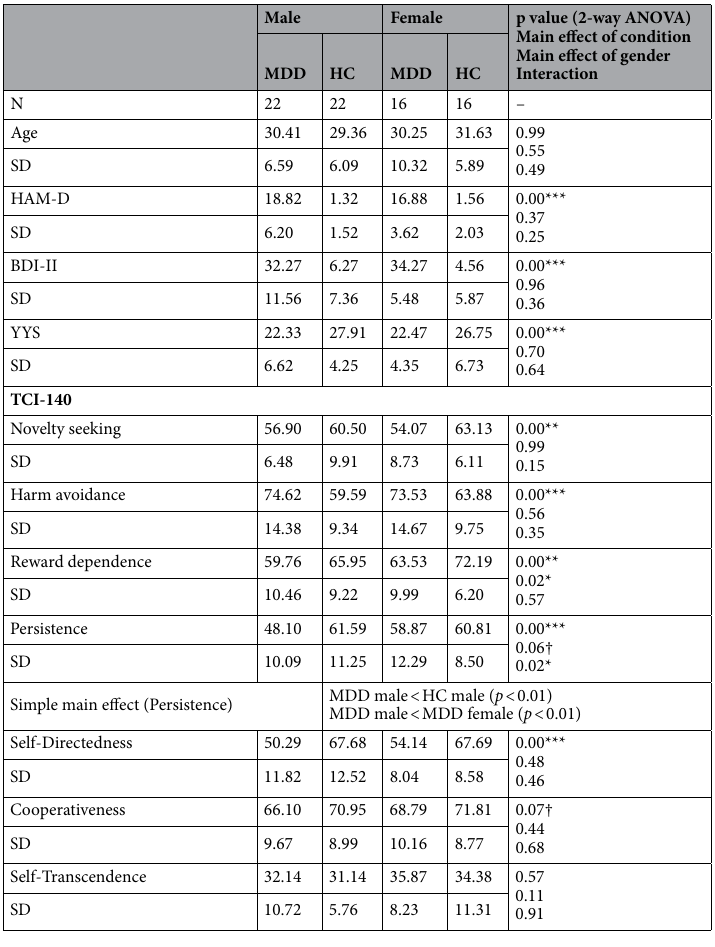
Table 1. Demographics and clinical variables of drug-free MDD patients and Healthy Controls (HC). † p < 0.10, * p < 0.05, ** p < 0.01, *** p < 0.001.